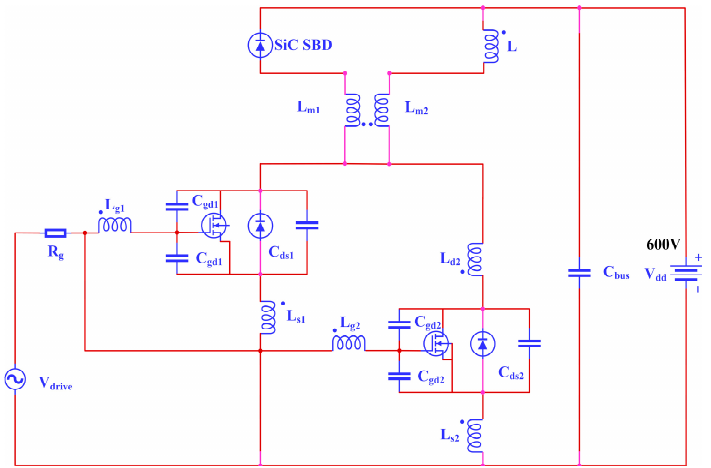
Figure 3. Principle design of the single-channel magnetic ferrite inductance-combined gate drive circuit.